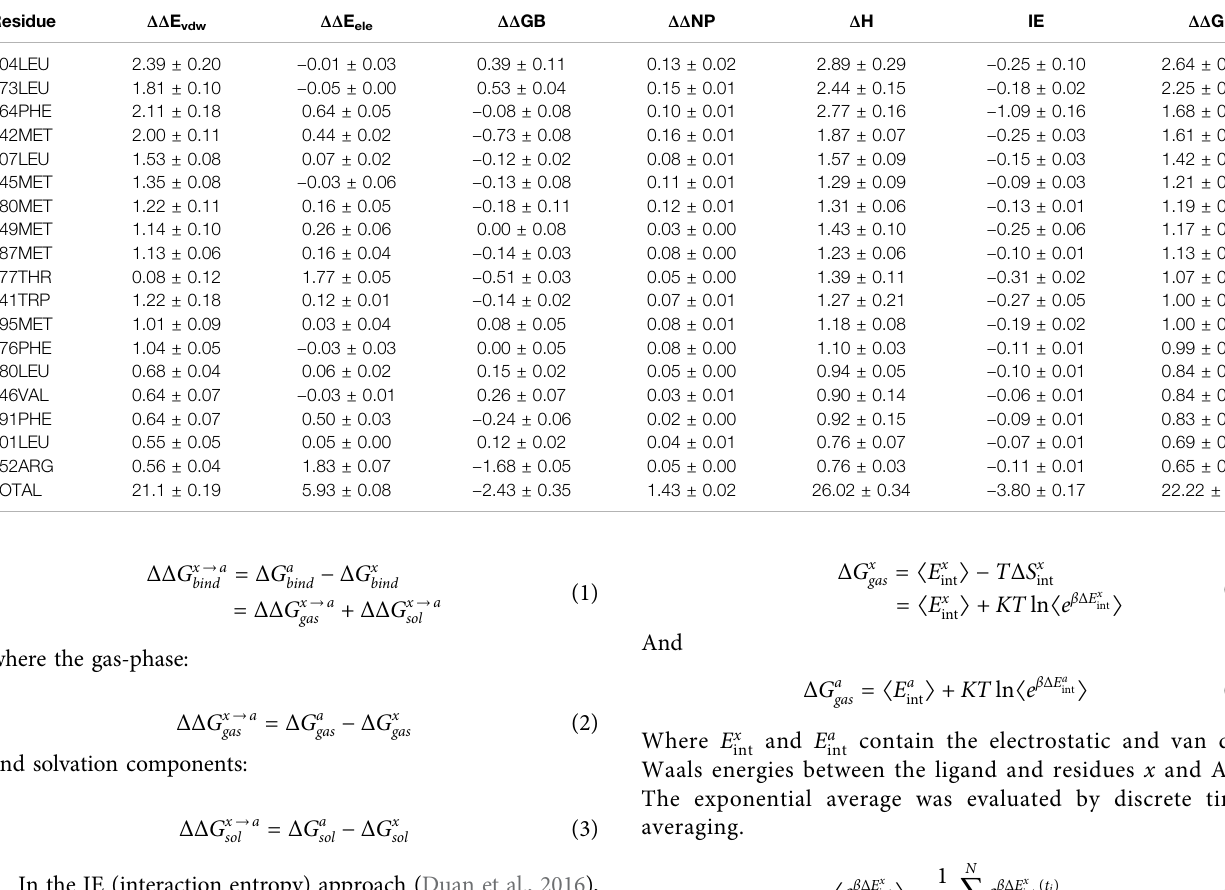
TABLE 1 | Residue-Speci fi c Binding Free Energies (kcal/mol) of 1i37 (Sack et al., 2001) calculated by